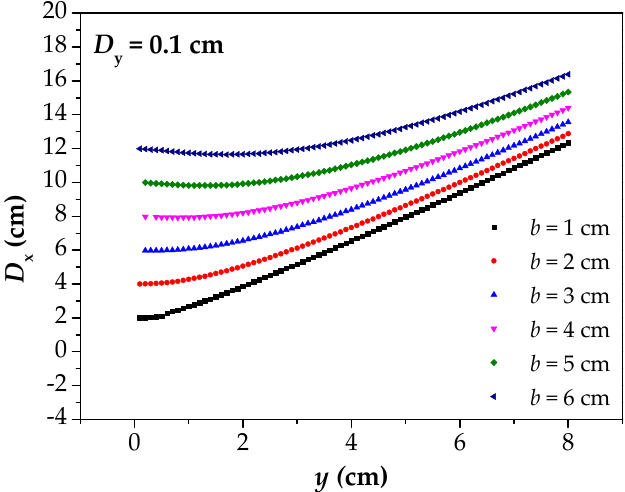
Figure 6. When D y is 0.1, the calculated results of D x under different b . D x : the intersecting point distance between curves of magnetic flux component of x direction at different lift off heights; D y : the difference between two lift off heights; b : the half of corrosion width.